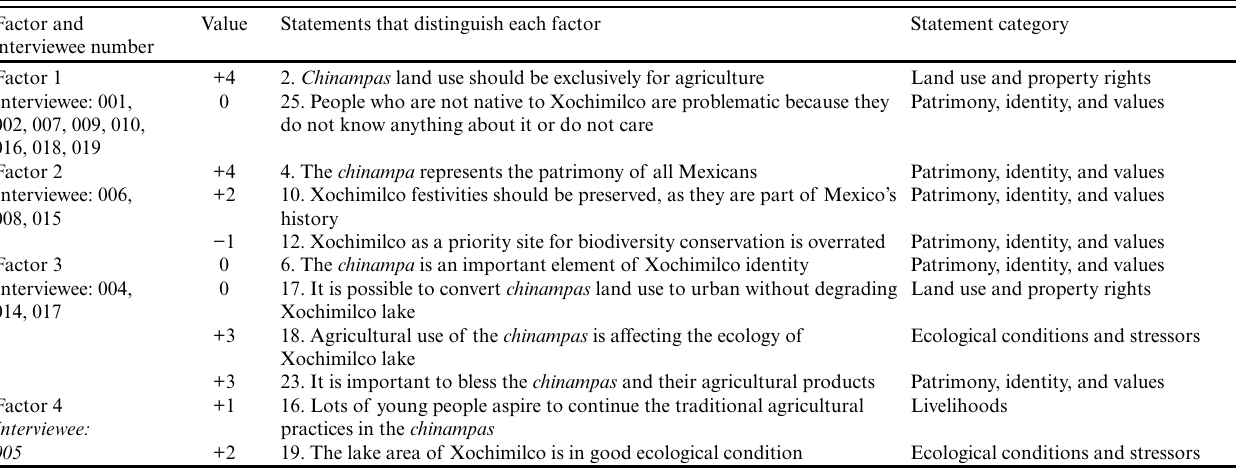
Table 2. Four perspectives that emerged from the Q method factor analysis as determined by statistical analysis of interviewees statement